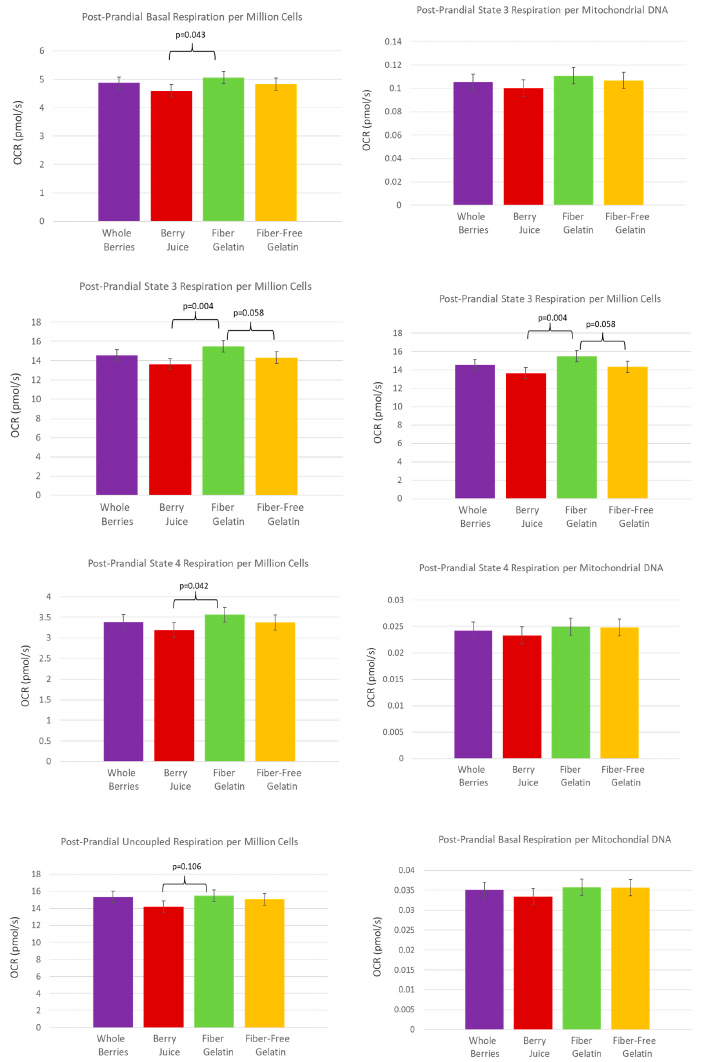
Figure 4. PBMC oxygen-consumption rate in the fed state after subjects consumed a test meal with whole berries, berry juice, fiber-enriched gelatin, or fiber-free gelatin, having also consumed the respective treatment for one week prior to the test meal.